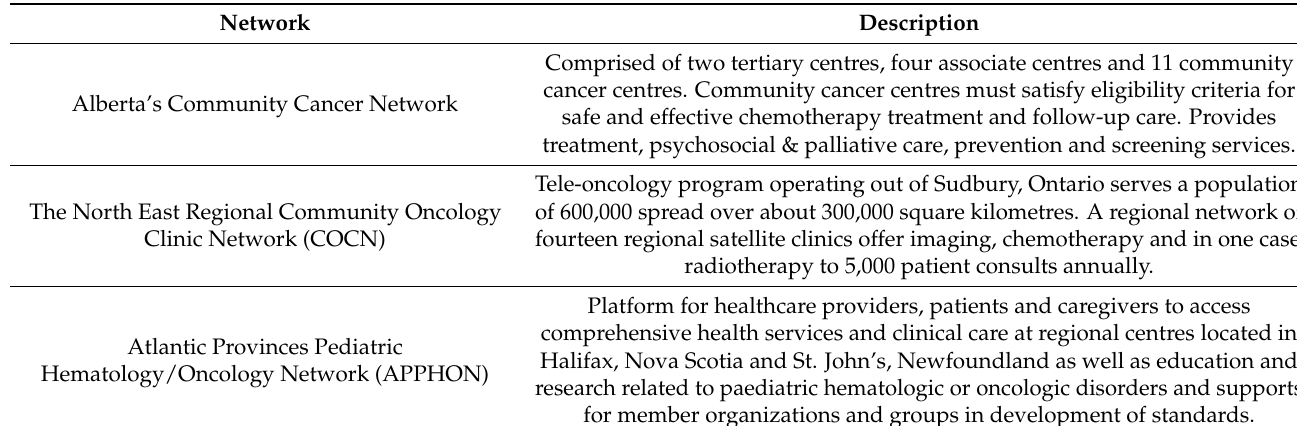
Table 1. Canadian examples of oncology networks/distributed models of care. Network